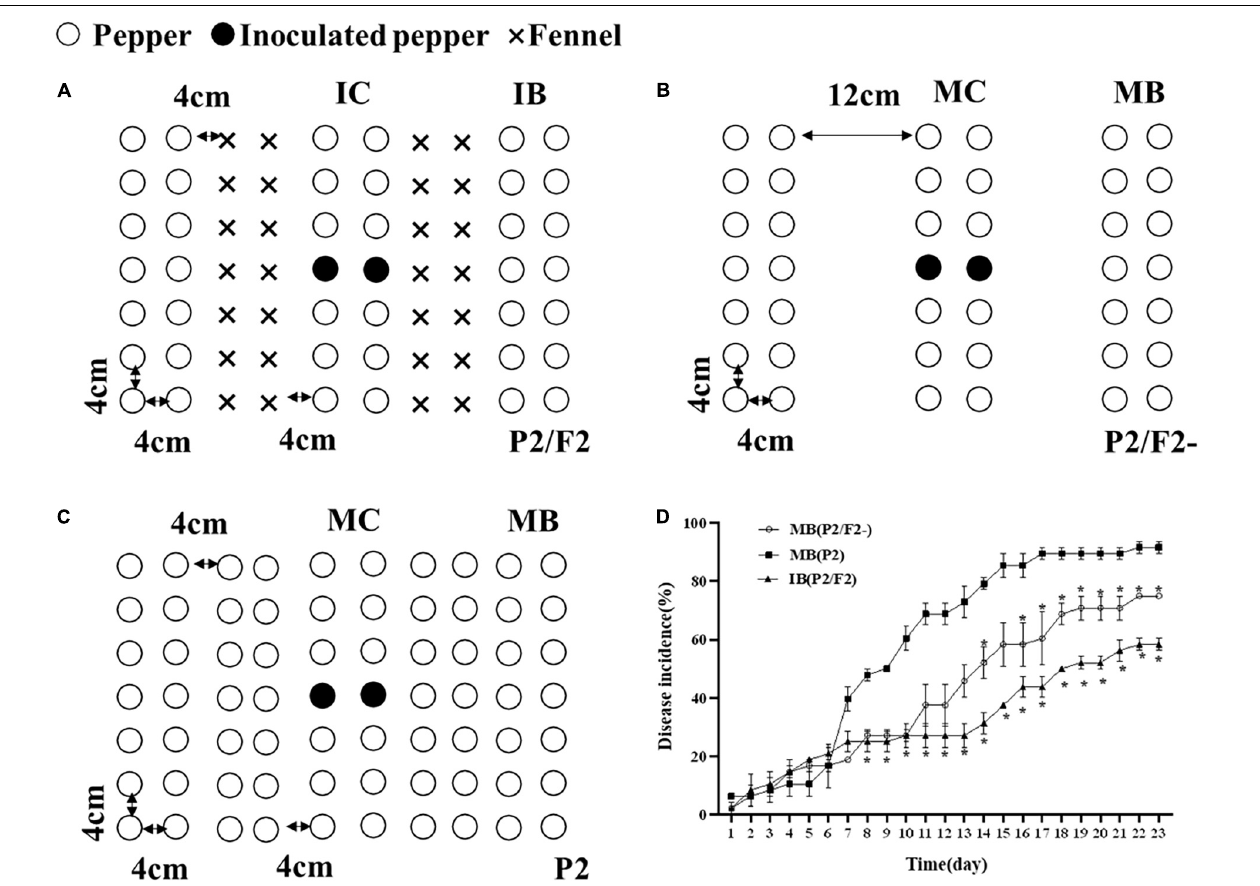
FIGURE 1 | Pepper and fennel intercropping patterns and their effects on pepper Phytophthora blight control in the field. (A) Pepper and fennel intercropping; (B) pepper/blank intercropping; (C) pepper monoculture; (D) disease incidence of Phytophthora pepper blight in monoculture systems, intercropping systems and the intercropping spacing without fennel rows. IB and MB indicate the borderlines (indicator line) in the intercropping and monoculture fields, respectively. IC and MC indicate the centerlines (inoculate online) in the intercropping and monoculture fields, respectively. Significant differences are based on Chi square test ( p < 0.05). The error bars indicate the standard errors of the means ( n = 3). The significant differences were compared between monoculture (P2), intercropping with fennel (P2/F2), and peppers spaced as in intercropping but without fennel (P2/F2-). *Indicate p < 0.05,